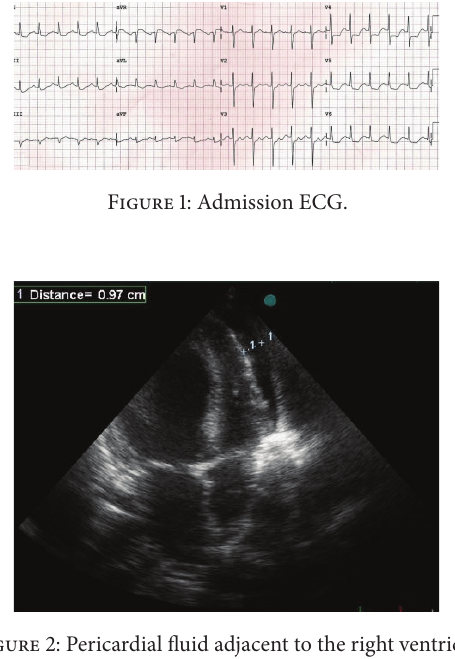
Figure 2: Pericardial fluid adjacent to the right